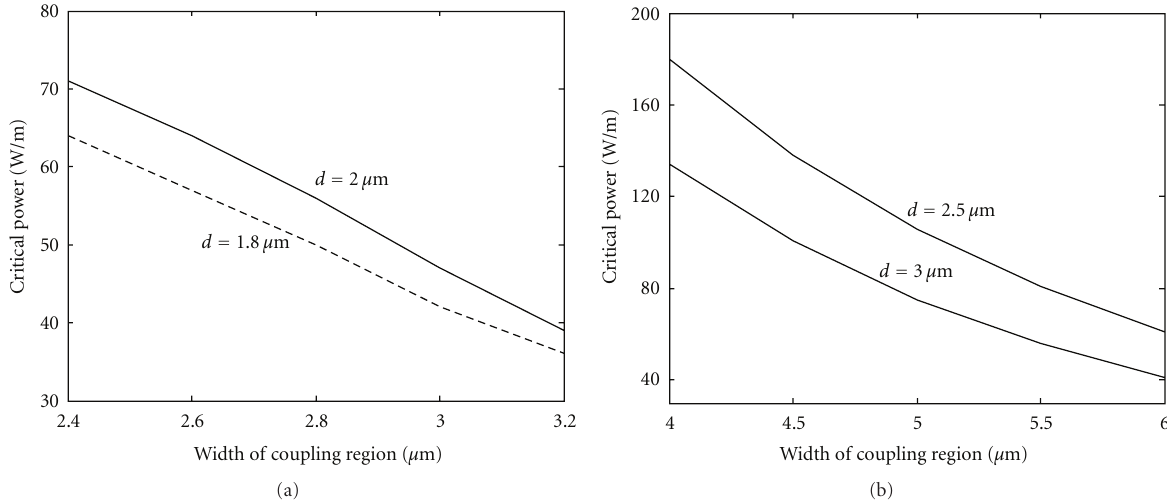
Figure 5: (a) Variation of critical power with core separation: nonlinear coupling region. (b) Variation of critical power with core separation: nonlinear core